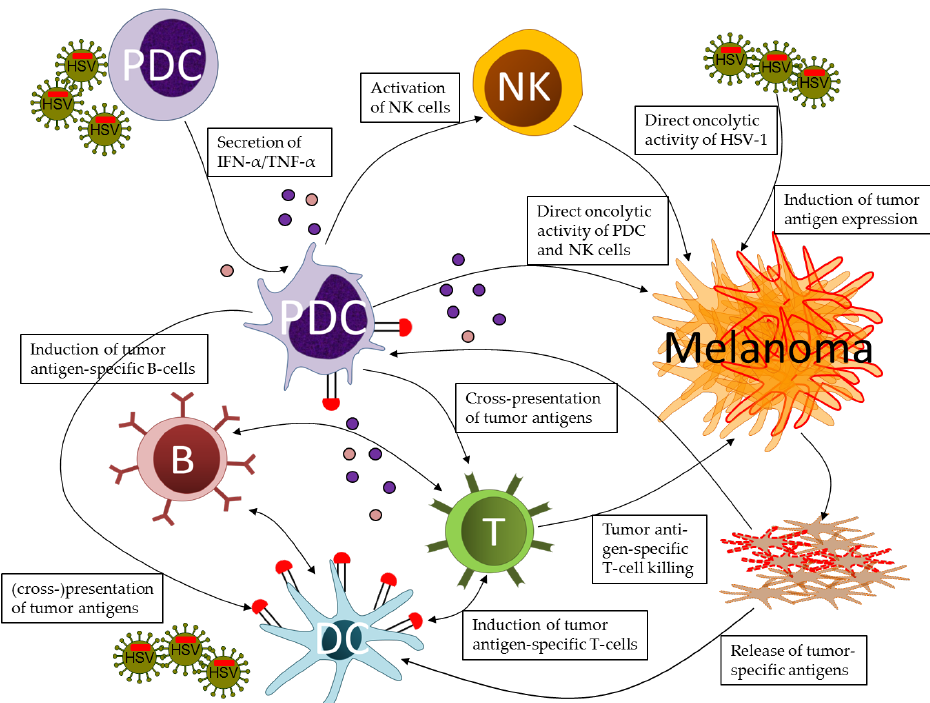
Figure 1. Prospects of plasmacytoid dendritic cells (pDC) in orchestrating innate and adaptive immune responses against melanoma in the context of oncolytic herpes simplex virus (HSV) infections. Upon stimulation by wild type, attenuated, or replication-deficient HSV-1, pDC secrete IFN-alpha